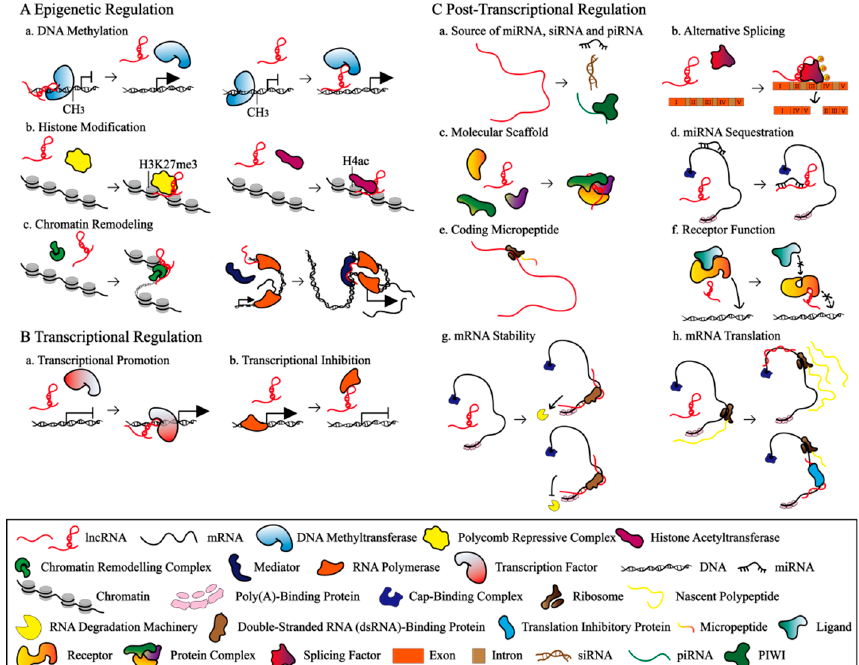
Figure 2. The epigenetic, transcriptional, and post-transcriptional mechanisms of lncRNAs. ( A ) Role of lncRNAs in the epigenetic regulation. ( a ) DNA methylation [25,26]. ( b ) Histone modification [27,28]. ( c ) Chromatin remodelling [29,30]. ( B ) Role of lncRNAs in transcriptional regulation. ( a , b ) LncRNAs regulate the binding of transcription factors to target genes [31,32]. ( C ) Role of lncRNAs in post-transcriptional regulation. ( a ) LncRNAs can serve as precursors of miRNAs, small interfering RNAs (siRNAs), or piwi-interacting RNAs (piRNAs) [33–35]. ( b ) LncRNAs can regulate alternative splicing [36]. ( c ) LncRNAs, such as metastasis-associated lung adenocarcinoma transcript 1 (MALAT1), can act as molecular sca ff olds, allowing the assembly of protein complexes [37]. ( d ) LncRNAs control mRNA levels by functioning as competing endogenous RNAs (ceRNAs) [38]. ( e ) Some lncRNAs may encode micropeptides [39,40]. ( f ) LncRNAs may block the activity of protein receptors